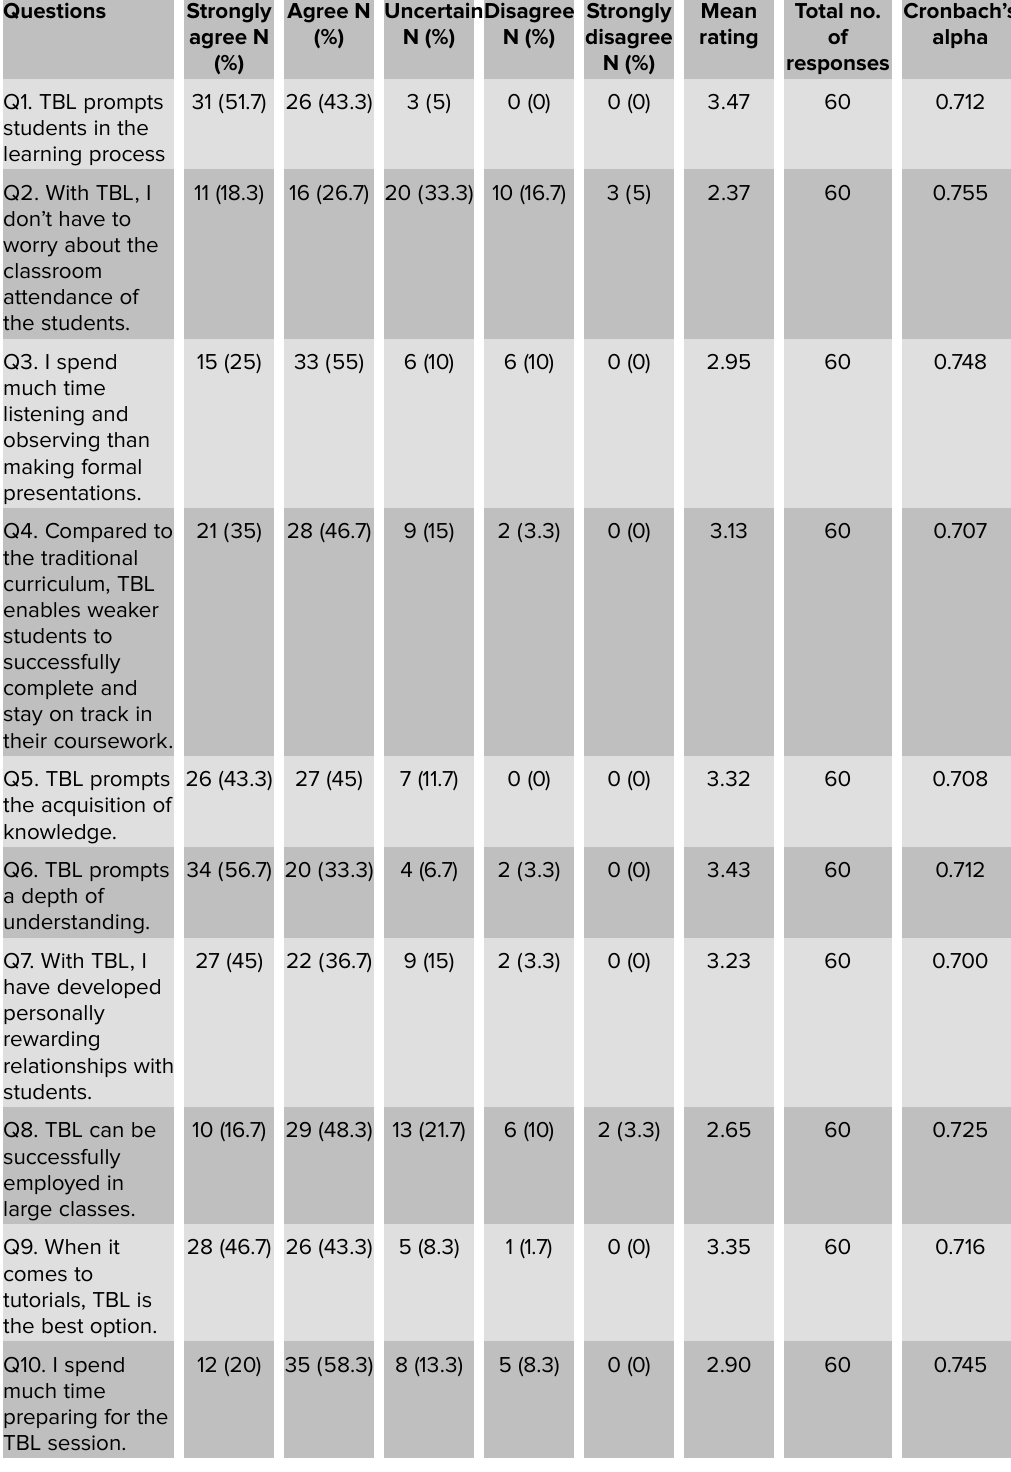
TABLE 1: Perception and attitude of participants toward team-based